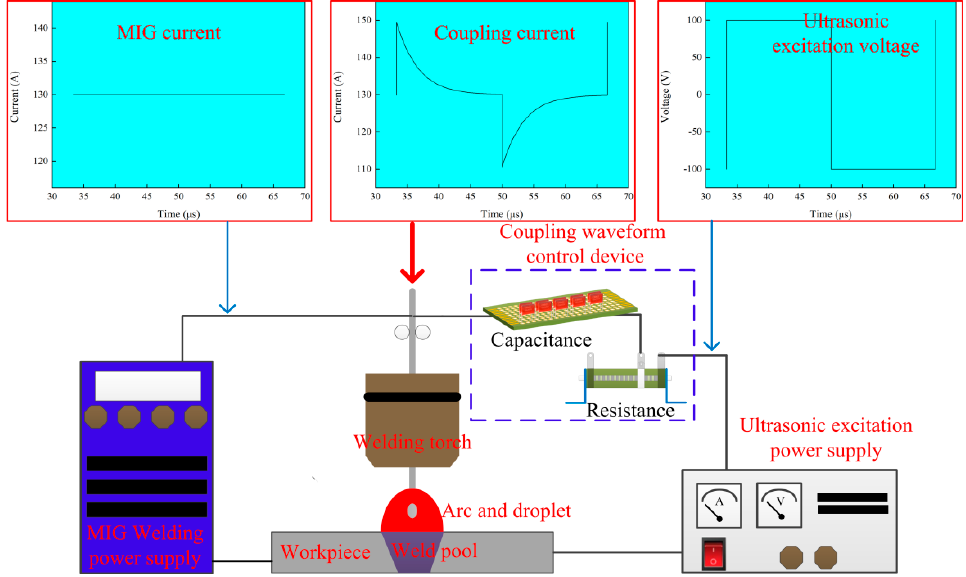
Figure 1. Schematic diagram of MIG arc ultrasonic welding system.